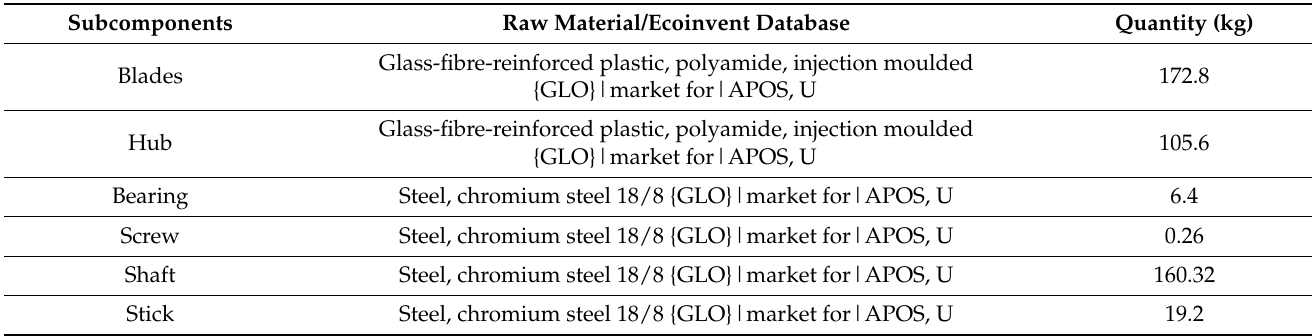
Table A2. Rotor inventory and matching Ecoinvent records.